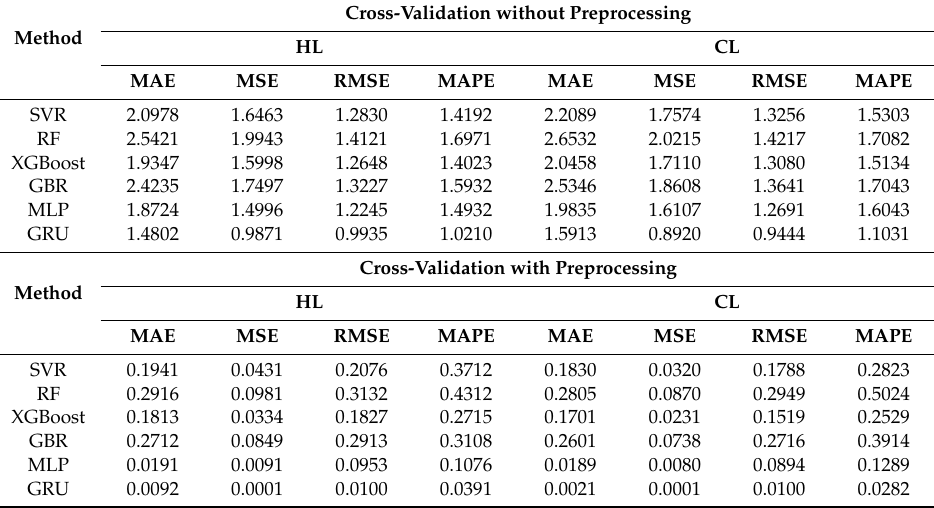
Table 5. Experimental results of various ML and DL models for SO prediction using the 10-fold method.